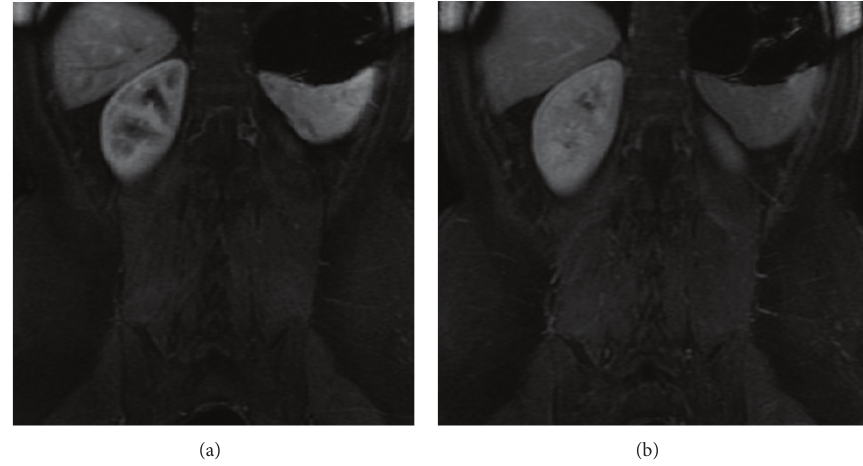
Figure5:Upside-downspleen.Coronalpostcontrast3D-GRET1wiwithfatsuppressionatthearterial(a)andvenous(b)phases.Anabnormal splenic rotation is seen. The hilum is superiorly located and the convex border is adjacent to the left